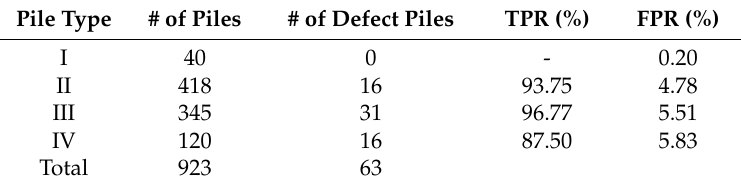
Table 4. Model performance summary based on the pile type-wise cross